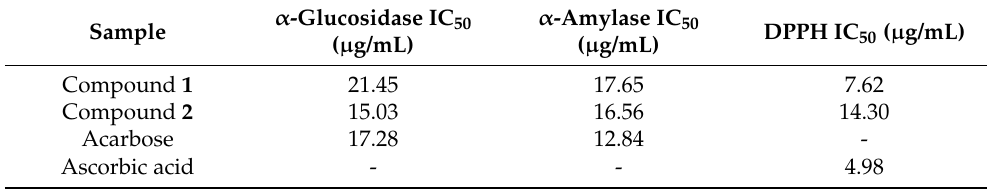
Table 5. α -Glucosidase, α -amylase and DPPH results of isolated compounds from Fragaria indica